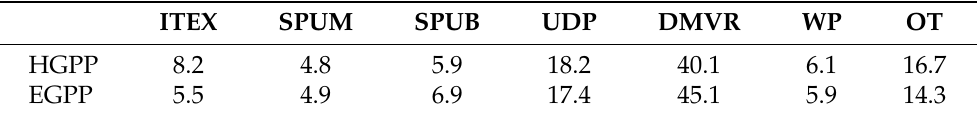
Table 5. Average processing times (in %) for each inter prediction block profiled over the HGPP and EGPP.